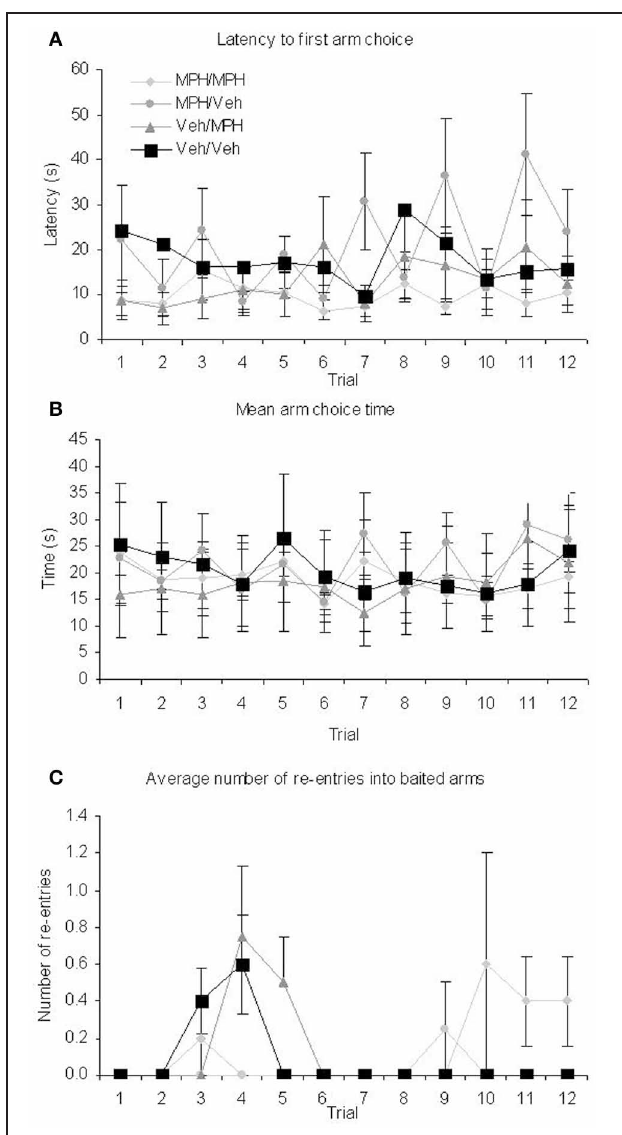
FIGURE 4 | Performanceduringthetrainingphase onthe3hDWST over the 12 trials run at this delay demonstrate that there were pre-existing group differences for the different drug treatment conditions used at the subsequent 6h delay for (A) latency (B) mean arm choice time (C) re-entry in to baited arms. All graphs show mean ±